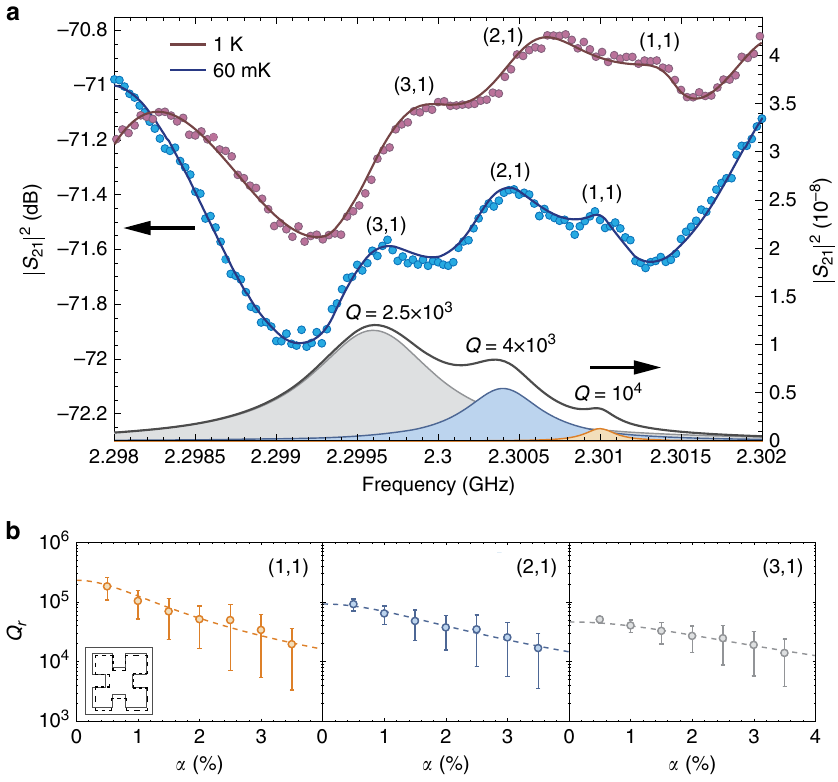
Fig. 4 Radiative quality factor of mechanical BICs at cryogenic temperatures. a Transmission spectrum of a PnC with 200 × 200 unit cells measured at 1 K and 60 mK, showing lower-order B 1 – BIC standing-wave resonances. The right axis shows the transmission via the three resonances, superposed (black curve) and individual, at 60 mK by removing the substrate background. b Simulated radiative quality factor of the three BIC modes using unit cells with disorders in dimensions b 0 s and c 0 s. α is the standard deviation of relative variation. Dashed lines are global fi tting using the model of Eq. (2). Error bar represents the standard deviation of Q r (Supplementary Note